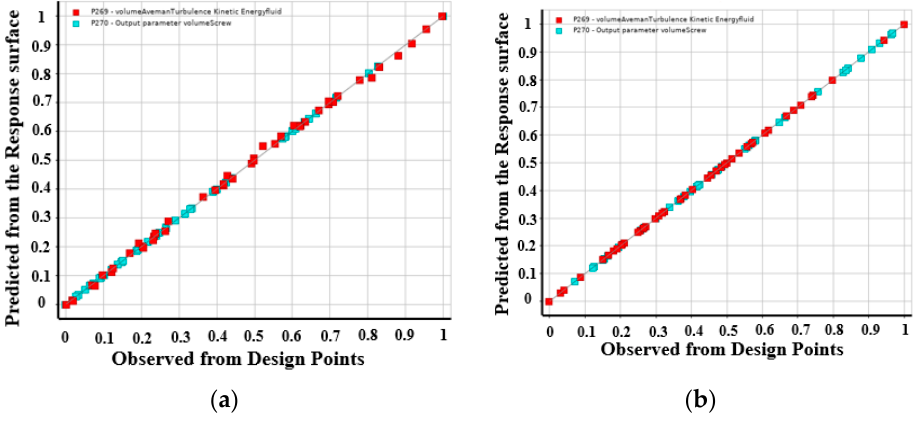
Figure 20. Verification of response surface using goodness of fit. ( a ) Before range revision of design parameters. ( b ) After range revision of design parameters.